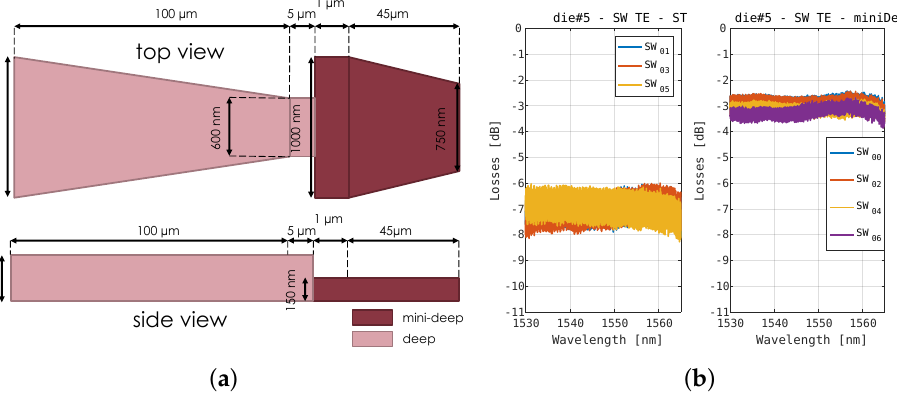
Figure 9. ( a ) Sketch and dimensions for the inverted tapers using two deeply etched cross-sections, ( b ) regular tapers performance and inverted tapers performance (left and right respectively).